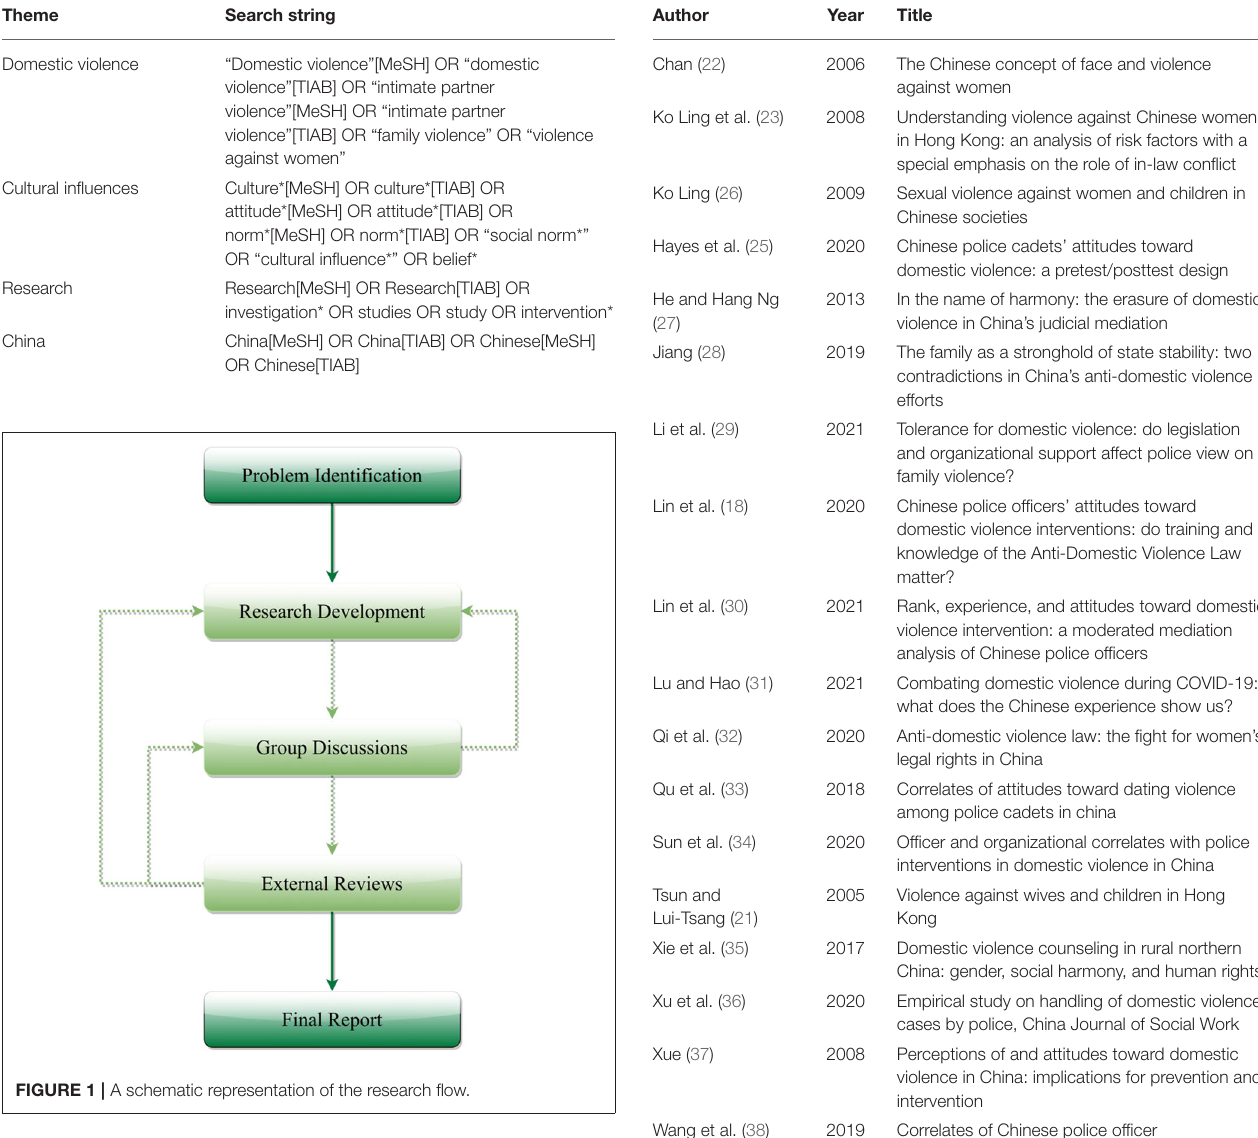
approaches, such as cross-sectional designs with large groups of participants [e.g., (23, 24)], or a pre-post experimental design with police officers (N = 401) in evaluating changing attitudes toward domestic violence [e.g., (25)]. Detailed information on the list of articles reviewed could be found in Table 2 .